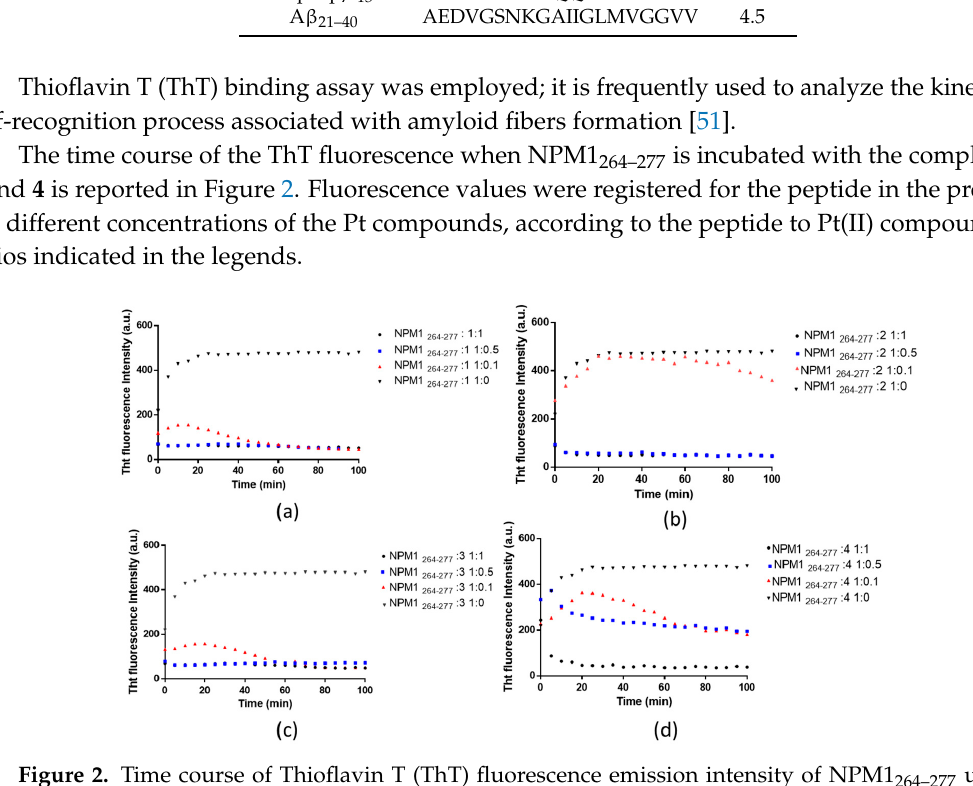
Table 1. Peptide sequences analyzed in this study.